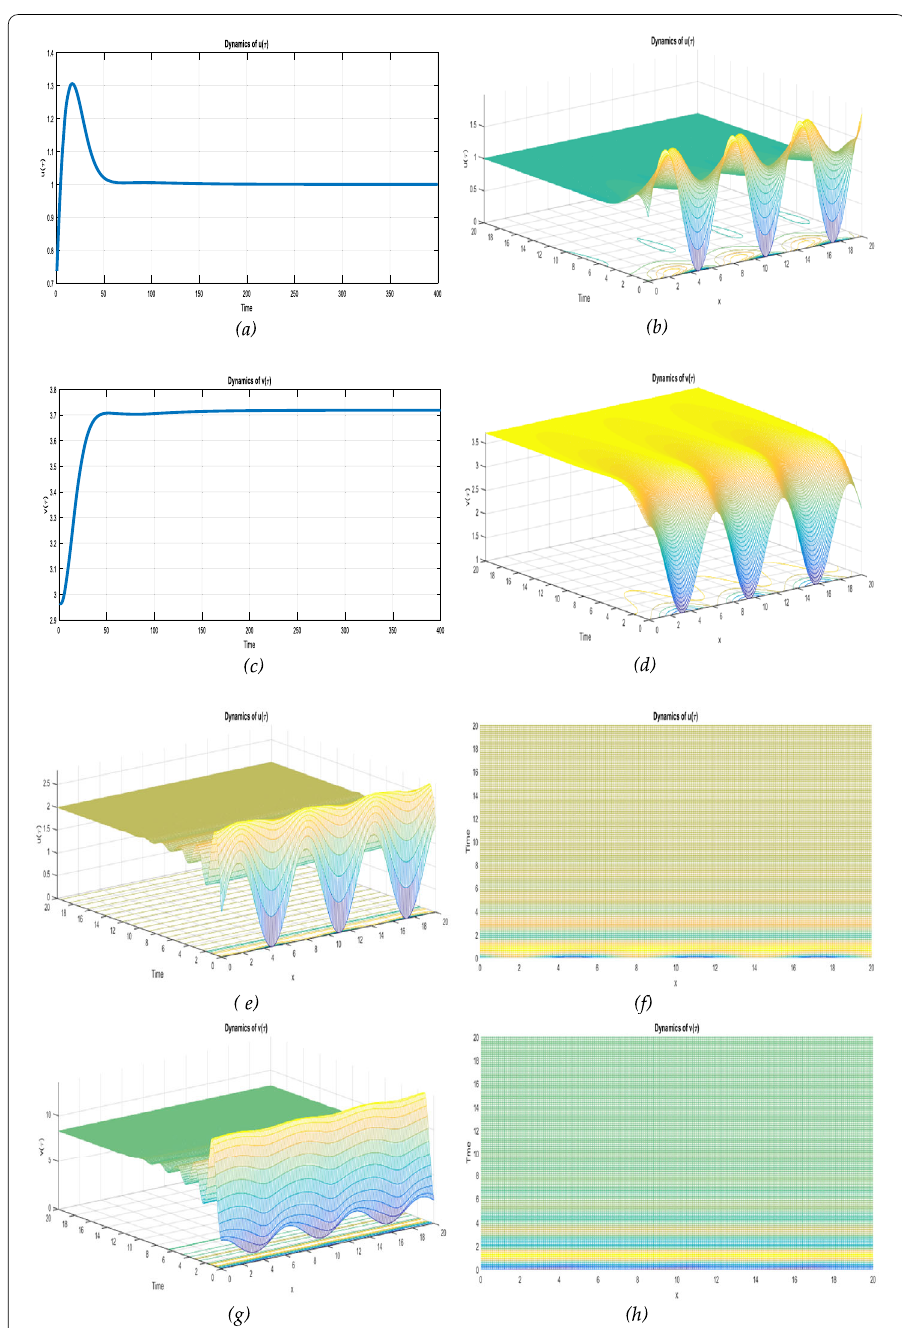
Figure 6 ( a )–( d ) Numerical solutions of system (49) using nonstandard finite difference scheme. Here, u 0 = 1 + sin( x ) and v 0 = 2 + cos( x ), with l = 5, m = 1, κ 1 = 0.01, and κ 2 = 0.01. (Top) The concentration of u ( τ ) is on the left while the concentration of v ( τ ) is on the right. (Bottom) The solutions u ( x , τ ) and v ( x , τ ) tend to the constant steady state. ( e )–( h ) Numerical solutions of system (49) using nonstandard finite difference scheme. Here, u 0 = 1+sin( x ) and v 0 = 2+cos( x ), with l = 10, m = 20, κ 1 = 0.01, and κ 2 = 0.01. (Top) The solutions v ( x , τ ) and u ( x , τ ) tend to the spatially nonhomogeneous steady state. (Bottom) The projected views onto the x τ -plane at τ = 20 for v ( x , τ ) and u ( x , τ ). The stripe structure invades the nonhomogeneous steady states for v ( x , τ ) and u ( x , τ